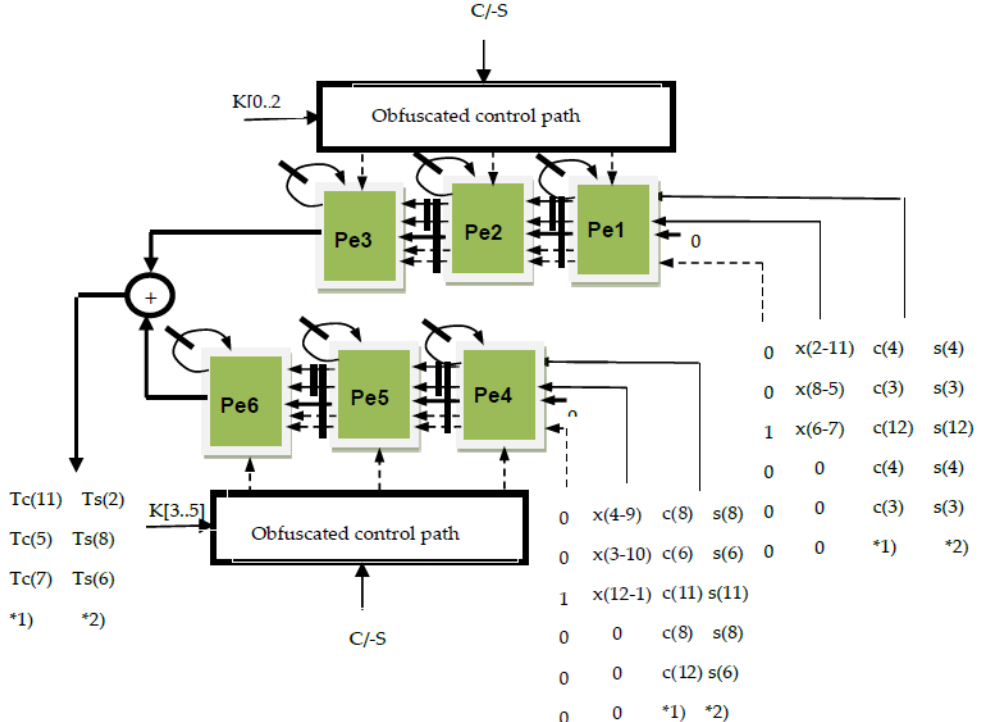
Figure 15. The unified VLSI architecture for DCT/DST-IV based on the unified algorithm for Equations (11) and (30) where *1) represents the cosine entry that is in parallel with *2) the sine entry; the correct entry is selected depending on the pre-processing stage to calculate what is needed (DCT-IV or DST-IV).